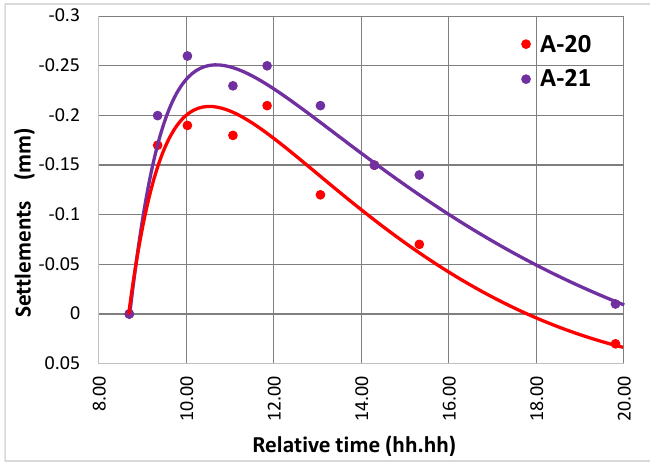
Figure 24. Results of penetration tests before and after soil injection. Based on comparative diagrams, at depths below 3 m, a certain increase in soil re- sistance is observed beneath both towers as a result of injection. Increasing the penetration resistance means that in a certain region of the soil around the foundation, the strength and stiffness of the soil are increased, which should have favourable consequences on the foundation bearing capacity. However, contrary to expectations, very soon after the be- ginning of the soil injection, next to north tower, an increase in settlement and the appear- ance of new cracks in the walls and arches of the Cathedral nave was observed. These effects were significantly less favourable than the ones observed during jacked-in piling. Based on the assumption that the settlement was the result of a large increase in pore pressure and a decrease in effective stresses in the clay, the contractor reduced the injec- tion speed, which prolonged the works. Despite this, the settlement continued at a lower intensity. In order to gain an insight into settlement dynamics, geodetic measurements were performed during and after the injection for 12 h straight, with final measurement conducted 24 h after the injection. The geodetic markers were measured on the south tower, above the injection point next to the wall. Settlement from 10 July 2018, at 08:42, until the next day, 11 July 2018, at 07:49 are shown in Figure 25. Figure 25. Movements of geodetic markers A-20 and A-21 during and after injection. The geodetic markers were measured eight times during working hours, and the ninth measurement was on the next day, shortly before the next injection session continued. According to the diagram, the markers showed upward movement that had a peak during the injection of 0.21 to 0.25 mm, but after injection ceased, the markers began to move downward. After 24 h, out of 0.25 mm rise, only 0.01 mm remained on the marker A-21. The marker A-20 showed a downward movement of 0.03 mm, after reaching 0.21 mm of upward movement. Based on the shape of the displacement curve, it can be concluded that, despite the initial rise during injection, both markers eventually have some settlement. Although the individual settlements are very small, when superimposed for each injection point (2 × 92 points), settlements of 8 to 10 mm were observed. In other words, during